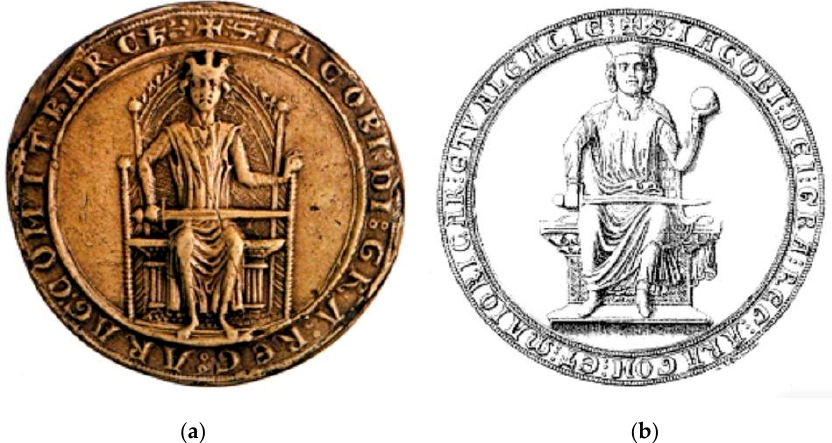
Figure 3. ( a ) Main seal of James I. Obverse. 1229. D/11222 © Archives Nationales de France.